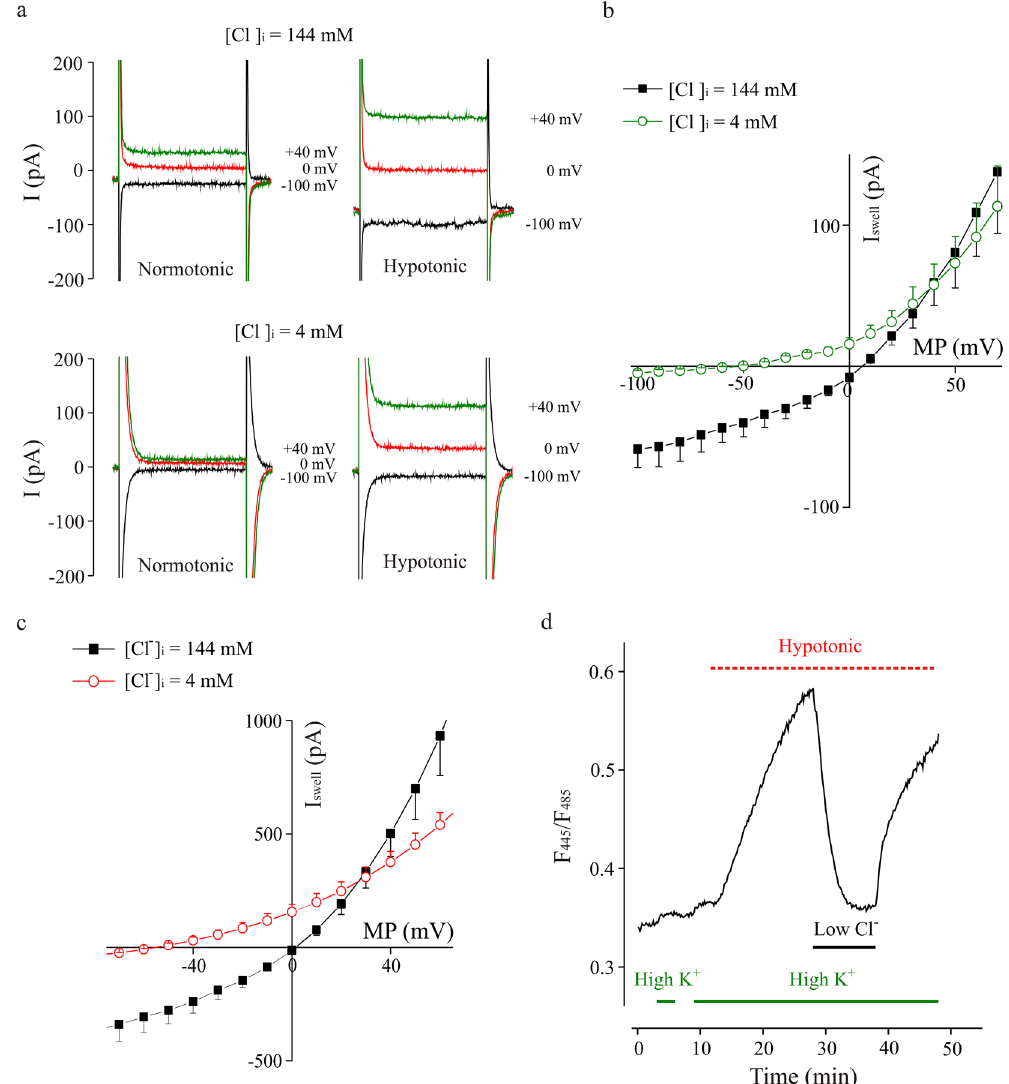
Figure 2. Hypotonic-activated current is driven by Cl − ions, in microglia cells. ( a ) Representative whole- cell currents recorded under acute application of the hypotonic extracellular solution (8–10% dilution), at the indicated membrane potentials, with a standard ([Cl − ] i = 144 mM; upper traces) or a low chloride ([Cl − ] i = 4 mM; lower traces) pipette solution. As indicated, the left traces were recorded in normotonic condition, just before applying the hypotonic medium; the right traces were recorded 21 minutes after hypotonic stimulation. ( b ) Current-voltage relationships of the currents recorded in control condition ([Cl − ] i = 144 mM; black squares; n = 3) and with a low chloride pipette solution ([Cl − ] i = 4 mM; green circles; n = 4; HP = − 70 mV) during acute application of hypotonic medium. Note the shift of the current reversal potential to more negative values. ( c ) Current-voltage relationships recorded in BV-2 cells, exposed acutely to a hypotonic medium (205 mOsm), in control condition ([Cl − ] i = 144 mM; black squares, n = 9) and lowering Cl − concentration ([Cl − ] i = 4 mM; red circles; n = 7) in the pipette solution. Graph represents the swell-activated current (I Swell ; subtraction of current in control to that under hypotonic stimulation) to eliminate the overlap with endogenous cell conductances. Note the shift of the current reversal potential to more negative values. ( d ) Time course of fluorescence ratio increase induced by the exposure of BV-2 cells, transfected with Cl − Sensor, to a hypotonic solution (200 mOsm, red bar) in normal or low extracellular Cl − (6 mM, black bar). Cells are concomitantly depolarized by high K + extracellular medium (60 mM, green bar), which per se did not cause significant changes in the fluorescence